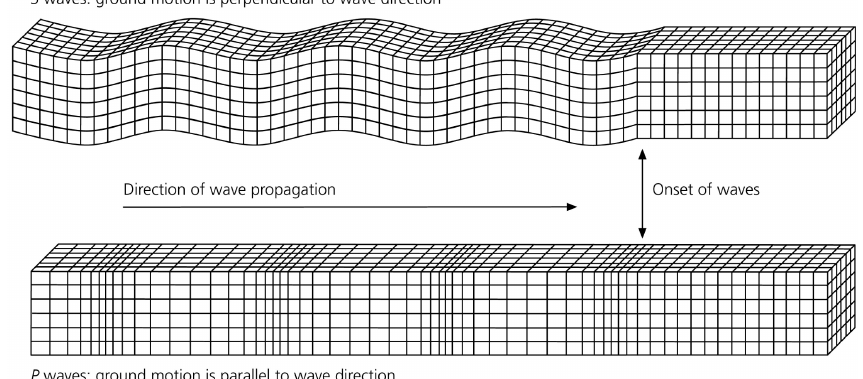
Figure 2. Illustration of ground motions produced by compressional ( P wave) and shear waves ( S wave). After Stein and Wysession (2003).